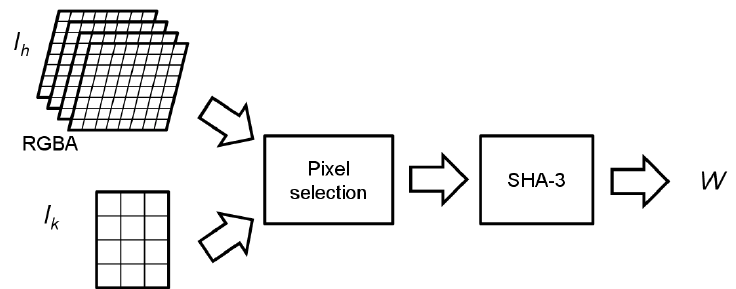
Figure 3. Diagram showing the main elements involved in watermark generation.